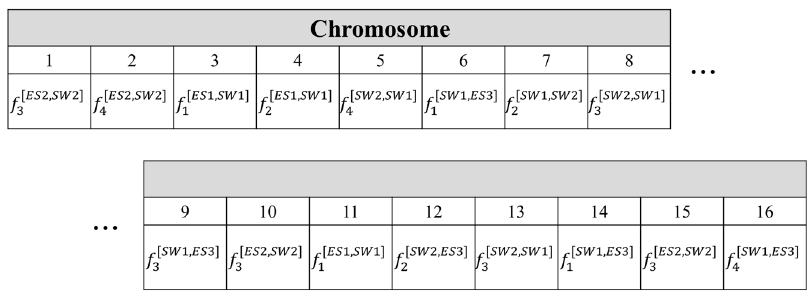
Figure 2. Example of chromosome generated using the information in Table 1. Table 1. Attributes of frames on the network shown in Figure 1.